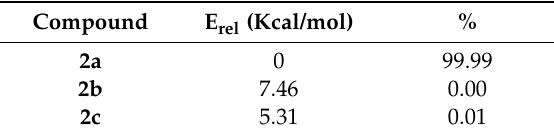
Figure 5. Rotamers for 2 .